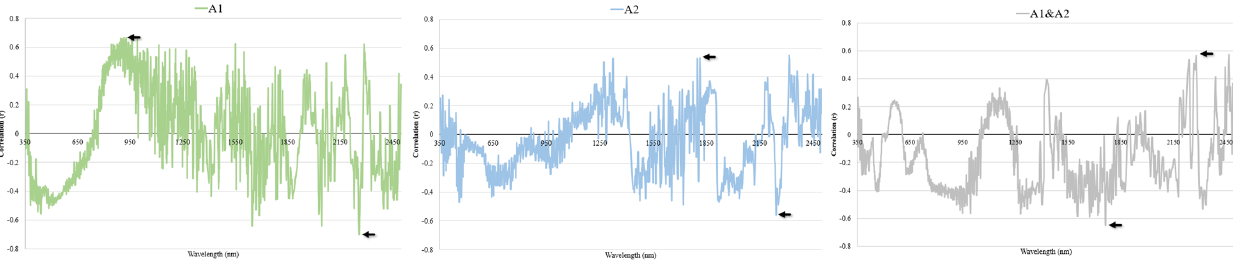
Figure 9. Pearson correlation between the SOC content and the first derivatives, for samples from ( a ) A1; ( b ) A2; and ( c ) A1&A2.